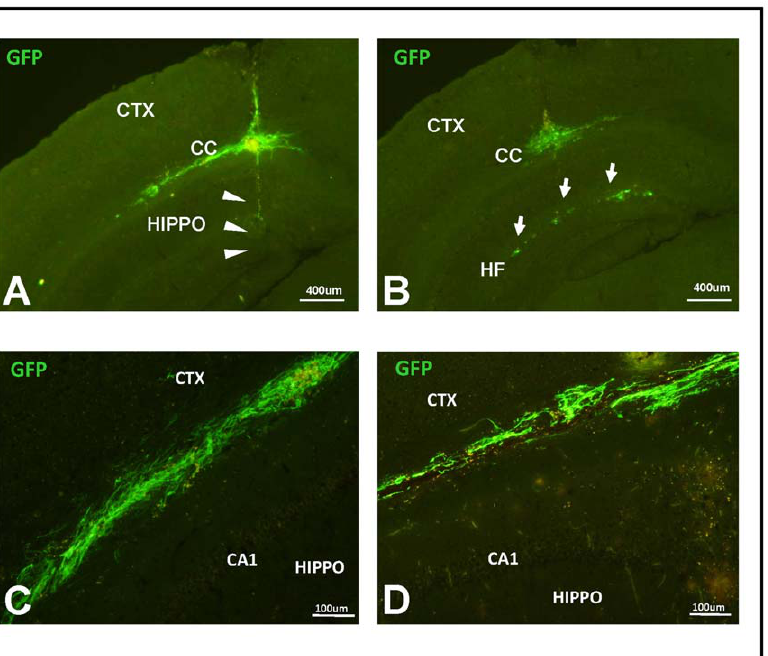
Figure 3. Distribution of long-term NSC engraftments in APPswe/PS1dE9 mice. Symptomatic APPswe/PS1dE9 mice received NSCs at three depths per infusion and were allowed to survive for one month. NSCs were mainly distributed in the corpus callosum despite evidence of needle track penetration into the hippocampal gray matter (A; arrowheads indicate approximate position NSCs were released). In some instances, NSCs formed secondary grafts in the hippocampal fissure (B; arrows). Closer inspection in NSCs engrafted in the corpus callosum of APPswe/PS1dE9 mice (C) and tetAPPsi mice (D) revealed these cells had an elongated morphology characteristic of migrating cells; however, cells did not exit into the cortex (CTX) or spread below CA1 neurons of the hippocampus (HIPPO). GFP expression was detected indirectly with an antibody specific to GFP in all panels.